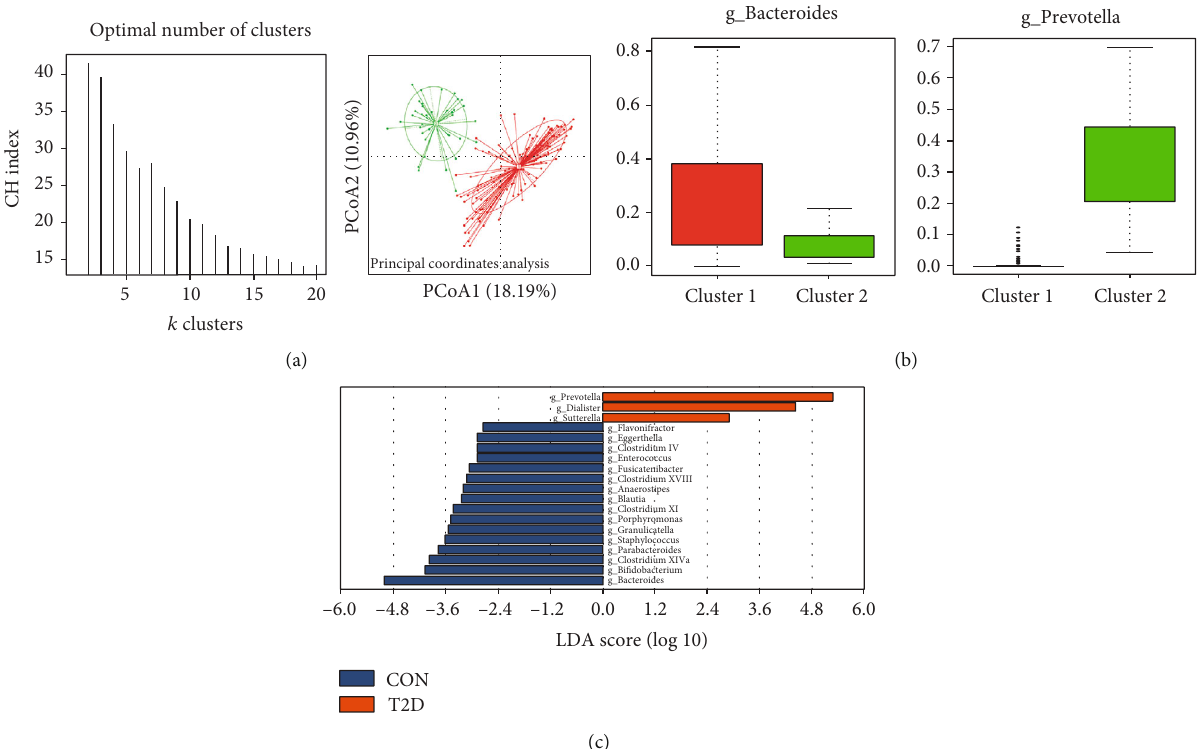
Figure 3: Enterotypes identi fi ed in 171 participants using PCoA. (a) Panel (A) shows that the data are most naturally separated into two clusters via LefSe (LDA E ff ectSize) analysis. The x -axis shows the cluster number, and the y -axis shows the Calinski-Harabasz index, which is a measure of cluster separation. Panel (B) shows the clustering on the fi rst two principal components. The red color represents enterotype 1 ( Bacteroides ), and the green color represents enterotype 2 ( Prevotella ). (b) Abundance index of Bacteroides and Prevotella in each enterotype. Boxes represent the interquartile range (IQR), and the line inside represents the median. PCoA: principal coordinates analysis. (c) LDA E ff ectSize analysis of two enterotypes. The x -axis shows the LDA score (log 10) after analysis and the y -axis shows the signi fi cantly di ff erential genus between two enterotypes. The LDA threshold value is correlation with age ( r = 0 : 392, r = 0 : 256 , both P < 0 : 05 ). 1 2 Blautia , Eggerthella , and Flavonifractor had a positive correlation with DAO ( r = 0 : 222, r = 0 : 309, r = 0 : 241 , all 1 2 3 P < 0 : 05 ). Bi fi dobacterium , Granulicatella , and Eggerthella had a positive correlation with LPS ( r = 0 : 246, r = 0 : 187, 1 2 r = 0 : 223 , all P < 0 : 05 ). Flavonifractor had a positive correla- 3 tion with TNF- α ( r = 0 : 214, P = 0 : 024 ) (Table S14).